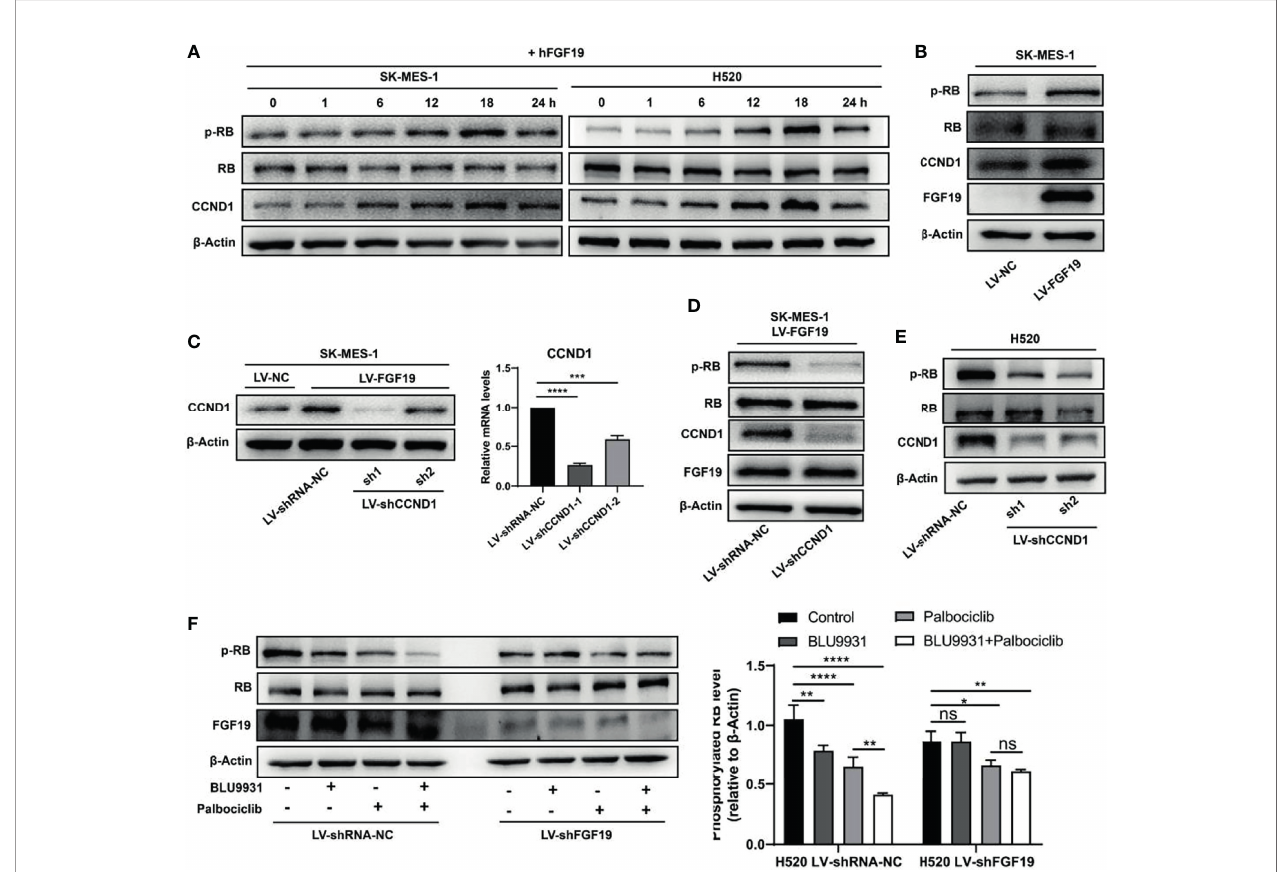
FIGURE 3 | FGF19 enhances CCND1-induced inactivation of RB. (A) rhFGF19 phosphorylated RB and promoted expression of CCND1 in SK-MES-1 and H520 cells in a time-dependent manner. (B) pRB and CCND1levels in FGF19 overexpression (SK-MES-1 LV-FGF19) and control (LV-NC) LUSC cells. (C) SK-MES-1 LV- FGF19 cells was transduced with CCND1-knockdown lentivirus (LV-shCCND1), or control lentivirus (LV-shRNA-NC) to construct stable cell lines and quanti fi cation of CCND1 in forms as cellular protein and mRNA. (D) pRB and CCND1 levels in FGF19 overexpression and CCND1-knockdown cells (SK-MES-1 LV-FGF19- shCCND1) and control (SK-MES-1 LV-NC-shRNA-NC) LUSC cells. (E) pRB and CCND1 levels in CCND1 knockdown cells (H520-shCCND1) and control (H520- shRNA-NC) LUSC cells. (F) pRB levels in FGF19-knockdown cells (H520-shFGF19) and control (H520-shRNA-NC) LUSC cells, treated with BLU9931, palbociclib, BLU9931 & palbociclib, or DMSO. Right panel: quanti fi cations of pRB. All the data were shown as the mean ± SD. * P < 0.05; ** P < 0.01; *** p < 0.001; **** p < 0.0001; ns, not signi fi